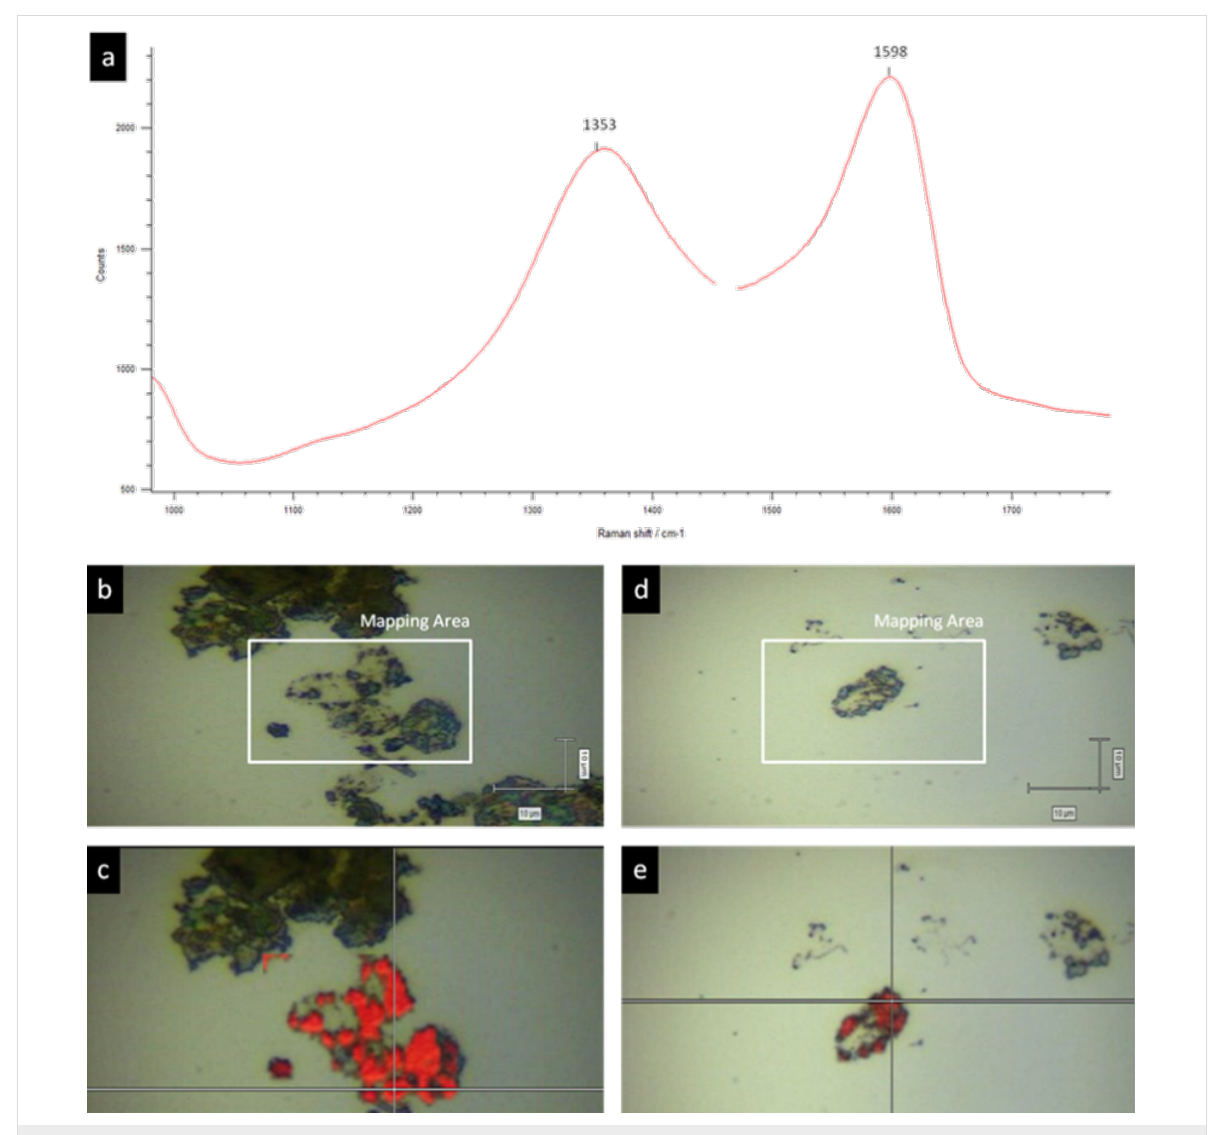
Figure 5: Raman of the GO-capsules. a) Raman spectra of GO sheets, G band located at 1598 cm -1 and D band at 1353 cm -1 . b) Image of the sample 2: (PSS/PAH) 20.5M + [GO/(PAH/PSS/PAH) 0.5M /GO] + (PSS/PAH) 0.5M capsules onto Si wafer with the selected area to be analysed. c) Mapping by intensity of the G band at 1598 cm -1 of the area selected in b. d) Image of sample 3 (PSS/PAH) 20.5M + [GO/PAH] 2.5 + (PSS/PAH) 0.5M capsules onto Si wafer with the selected area to be analysed. e) Mapping by intensity of the G band at 1598 cm -1 of the area selected in